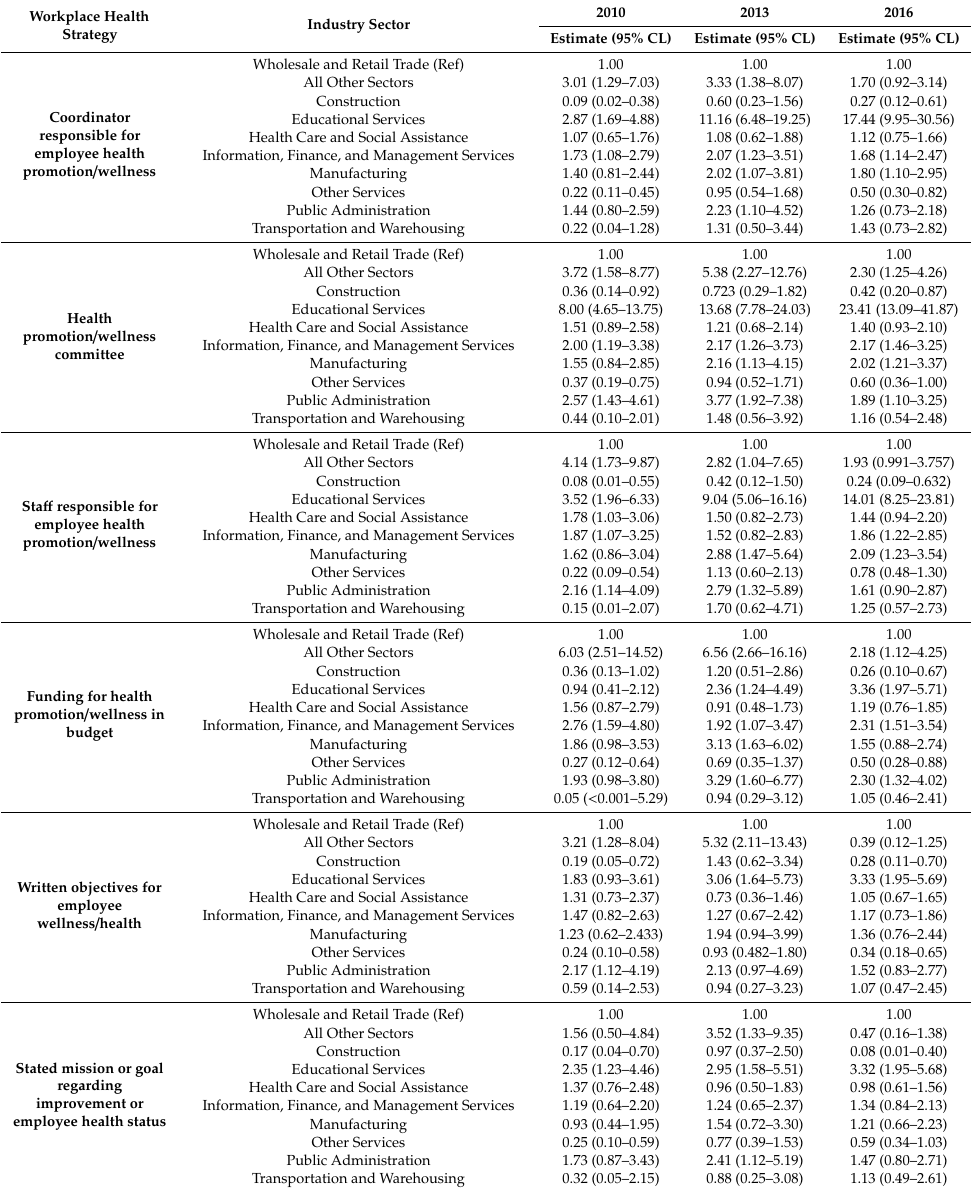
Table 3. Multivariable adjusted odds of implementing workplace health strategies stratified by year and industry